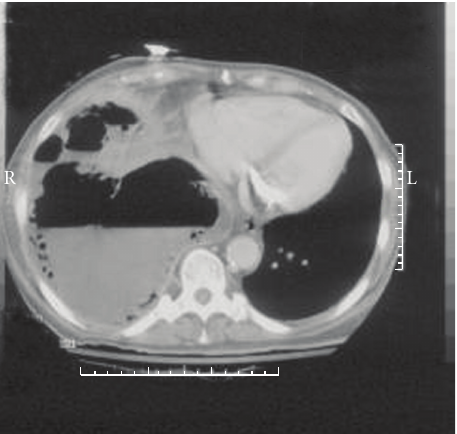
Figure 4: Representative section from the patient’s chest CT scan, performed during the second admission. Most of the right chest is taken up by multiple collections of fluid and gas. Note the leftward deviation of the mediastinal